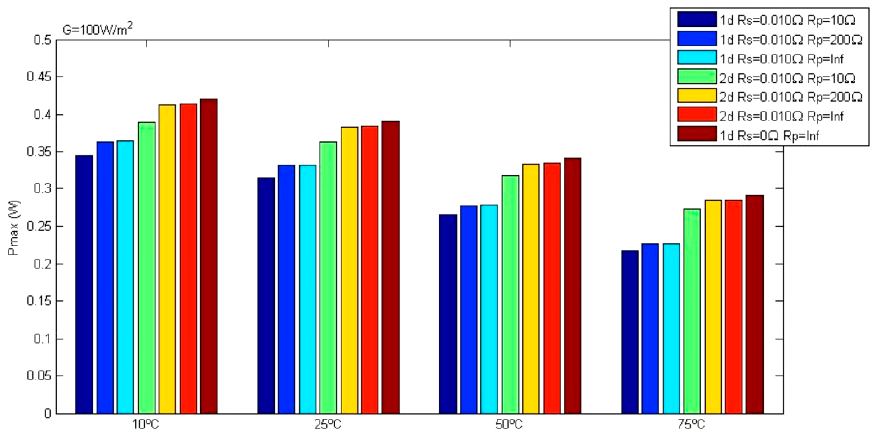
Figure 15. Maximum power as a function of temperature (G = 500 W/m 2 ).